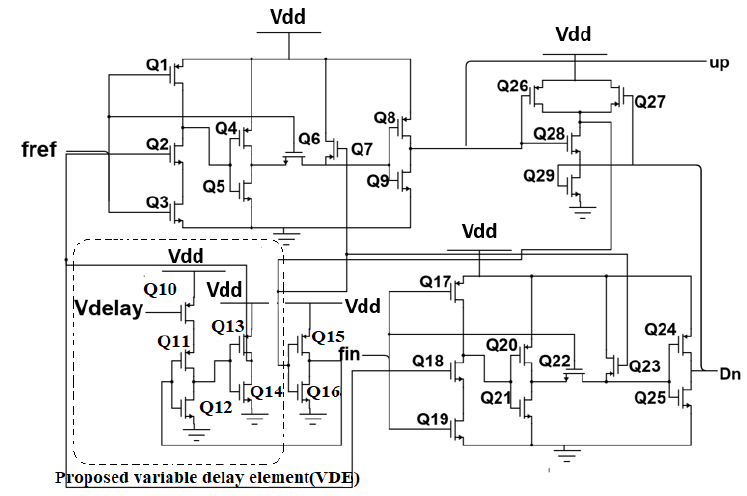
Figure 4. Circuit diagram of the PFD with proposed variable-delay